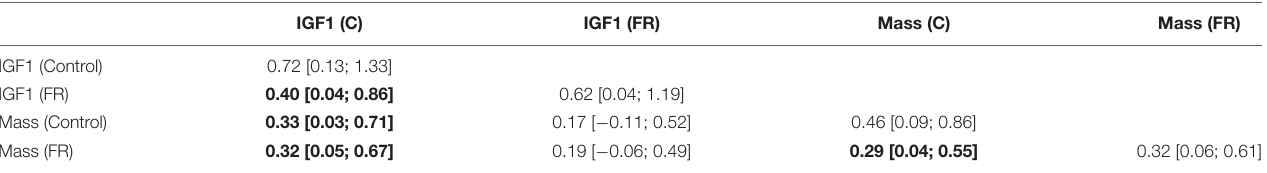
TABLE 2 | Variance-covariance matrix from the multivariate MCMCglmm model including IGF-1 and body mass under each treatment (control, “C” or food restricted,